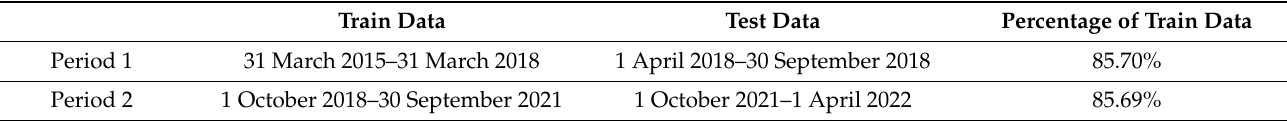
Table 3. Interval division of training samples and test samples.